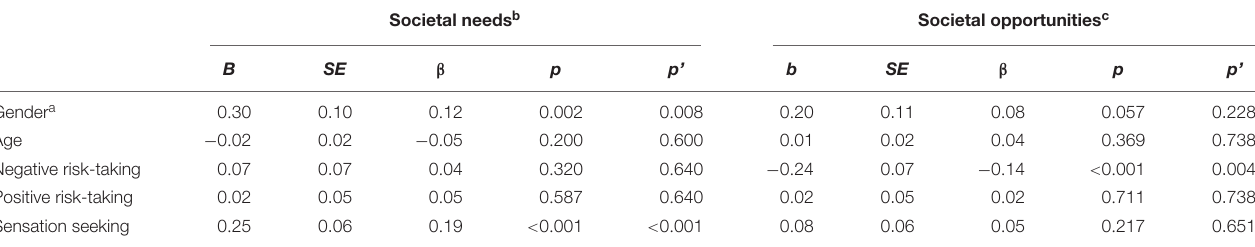
TABLE 3 | Coefficients for stepwise regression analyses with age, gender (step 1), risk-taking (step 2) and sensation seeking (step 3) as predictors of societal needs and opportunities.